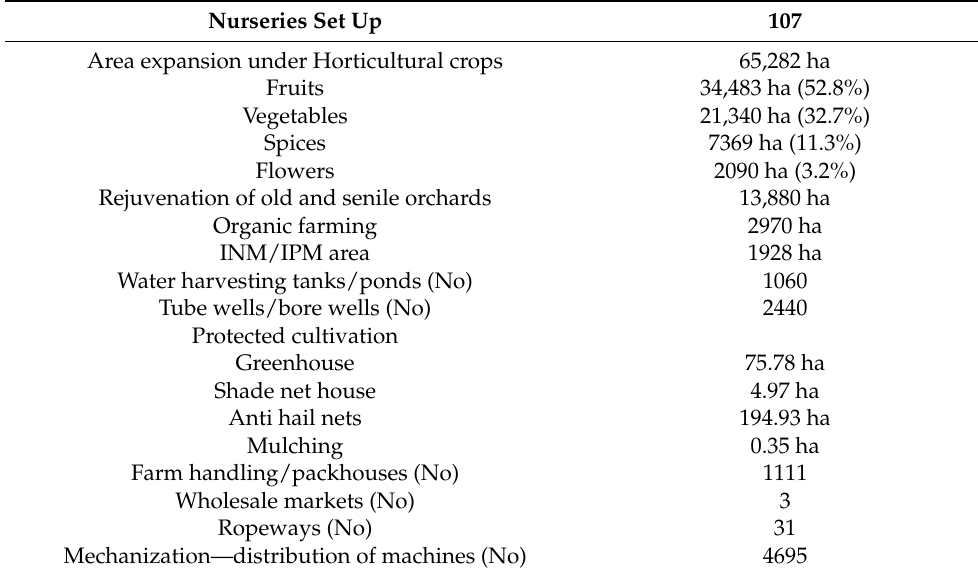
Table 4. Physical progress under HMNEH program, Uttarakhand, 2015-16.